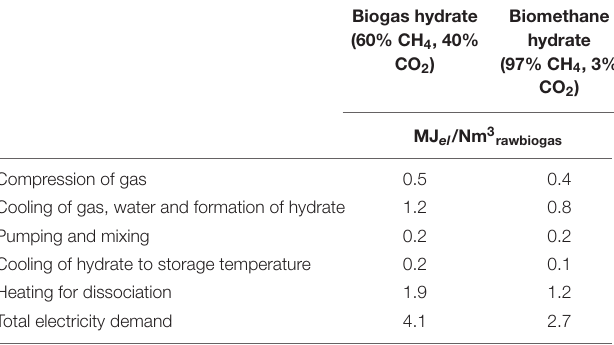
TABLE 3 | Electricity demand for the formation, storage and dissociation of hydrates.